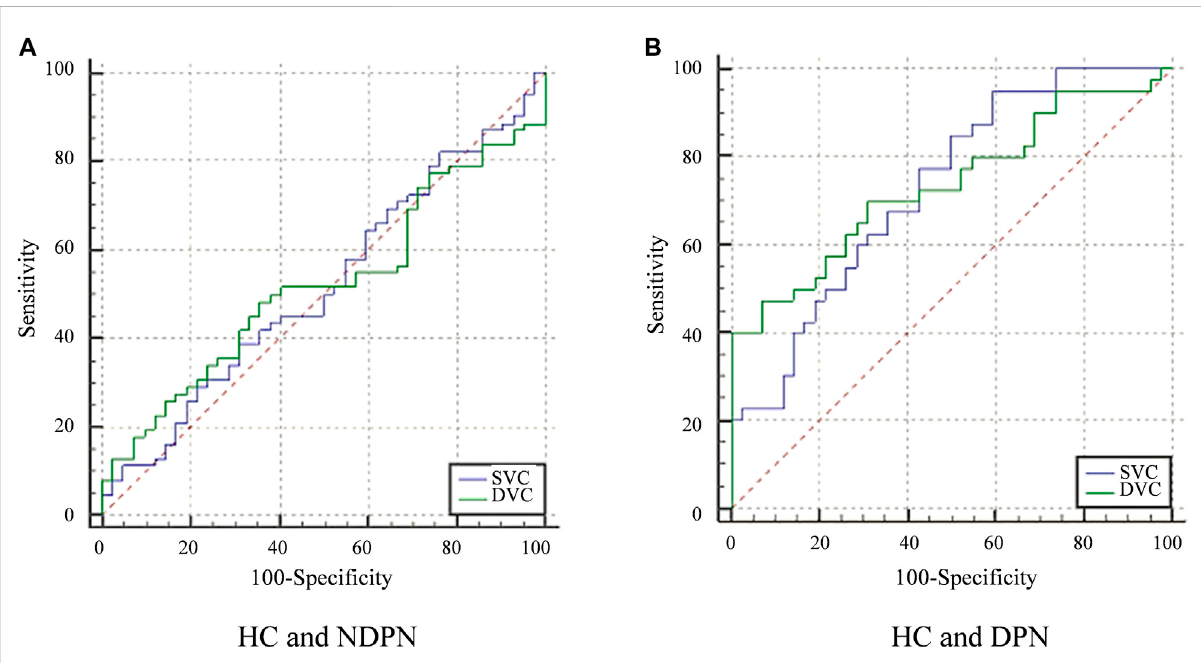
FIGURE 3 ROC curve analysis of VLD in the SVC and DVC. (A) The diagnostic ef fi ciency of VLD value of NDPN group in different levels. (B) The diagnostic ef fi ciency VLD value of the DPN group. Greenline: The ROC of DVC. Blueline: The ROC of SVC.